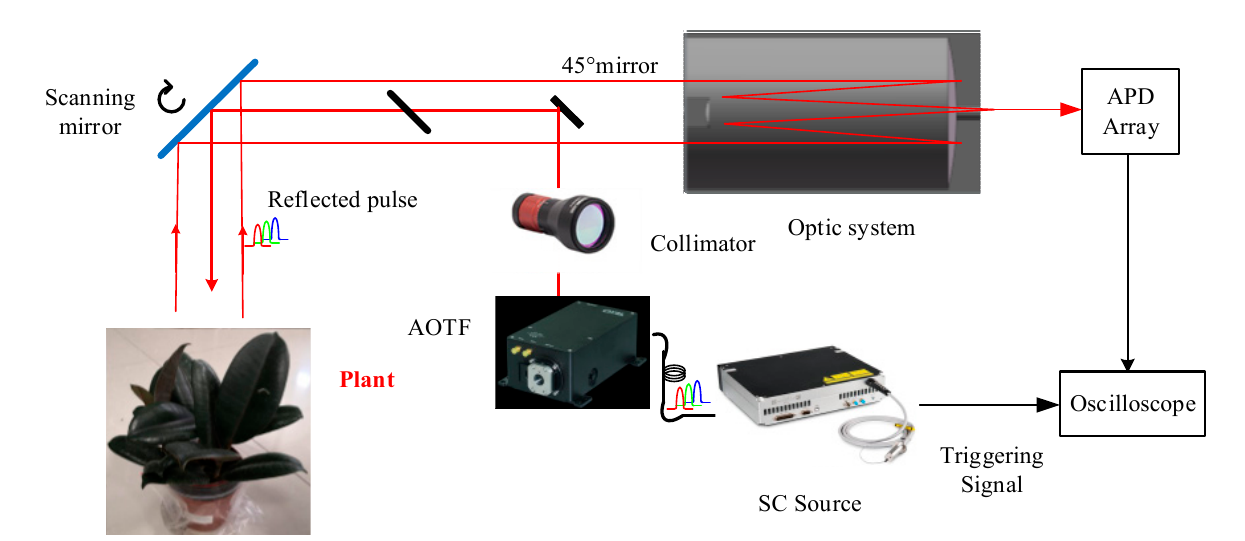
Figure 1. Architecture and working flow of the employed AOTF-HSL.